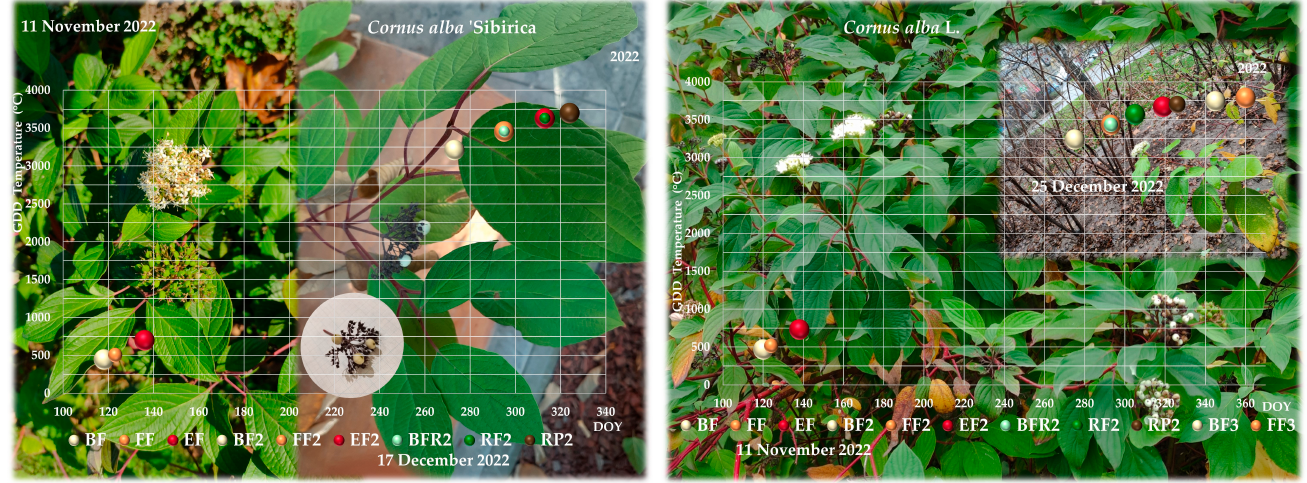
Figure 11. Phenological observations: GDD and DOY for the beginning of first flowering (BF), full first flowering (FF), the end of first flowering (EF), the beginning of second flowering (BF2), full second flowering (FF2), the end of second flowering (EF2), RF2 (second appearance of first ripe fruits), RP2 (second ripening of fruits), (EF2), the beginning of third flowering (BF3), and full third flowering (FF3) for Siberian Dogwood (left) and Tartarian Dogwood (right) in 2022.